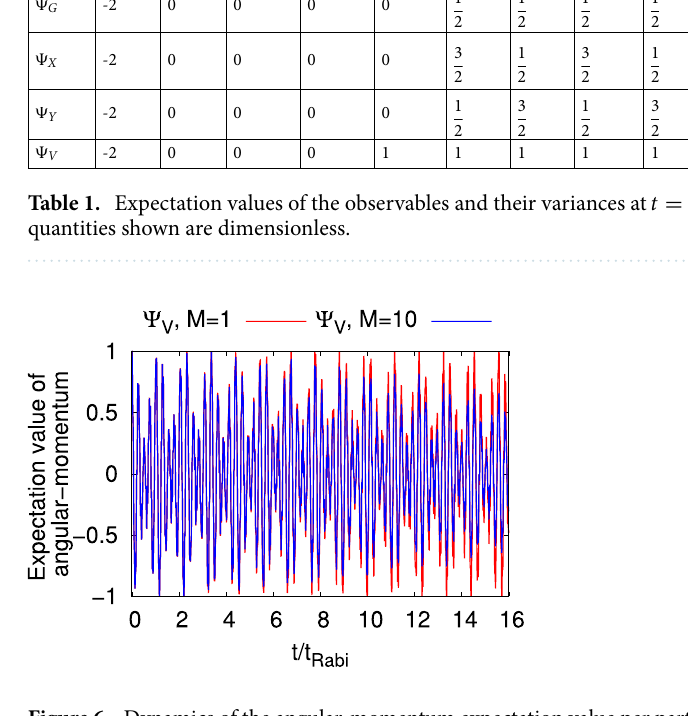
Figure 6. Dynamics of the angular-momentum expectation value per particle, 2D double-well for the vortex state (� V ) with N is presented in red and corresponding many-body result ( M for more details. The quantities shown are